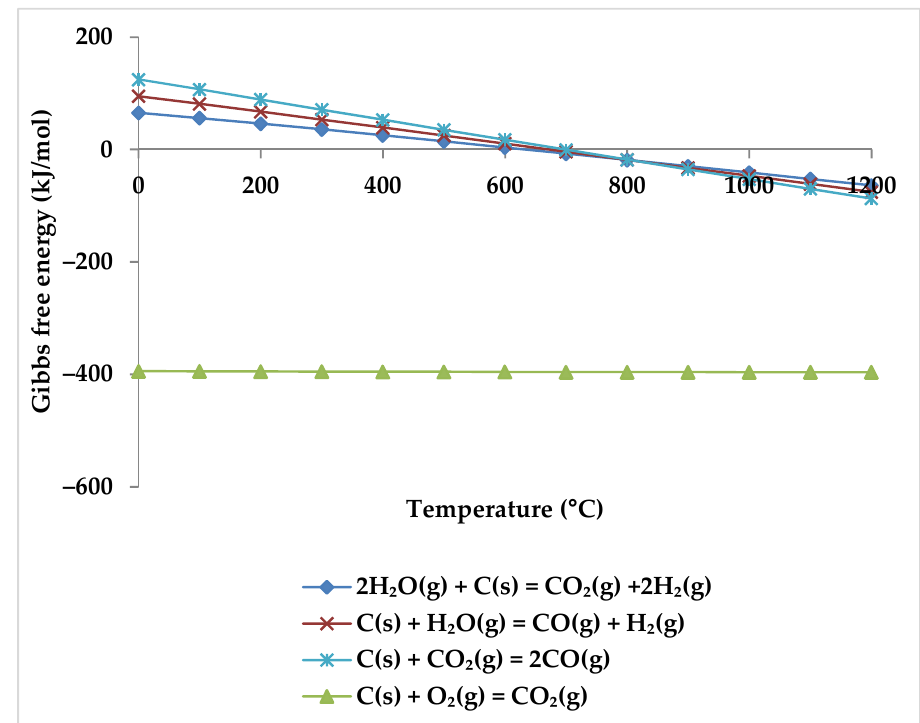
Figure 15. Gibbs free energy diagram for carbon gasification reactions.